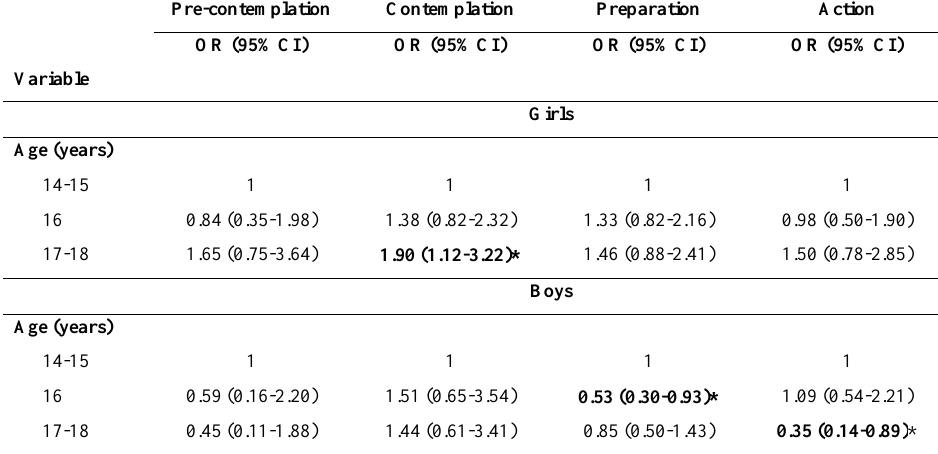
Table 2. Characterization of older individuals enrolled in the study